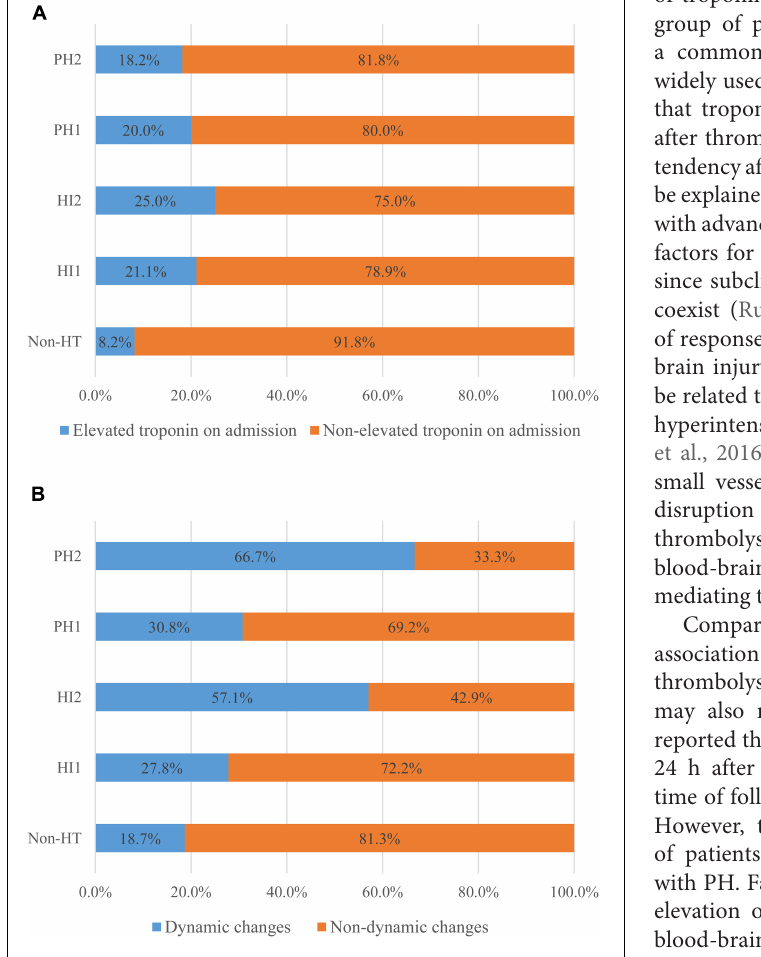
FIGURE 1 | Differences in troponin elevation on admission (A) and troponin dynamic changes (B) between groups with non-HT and other HT